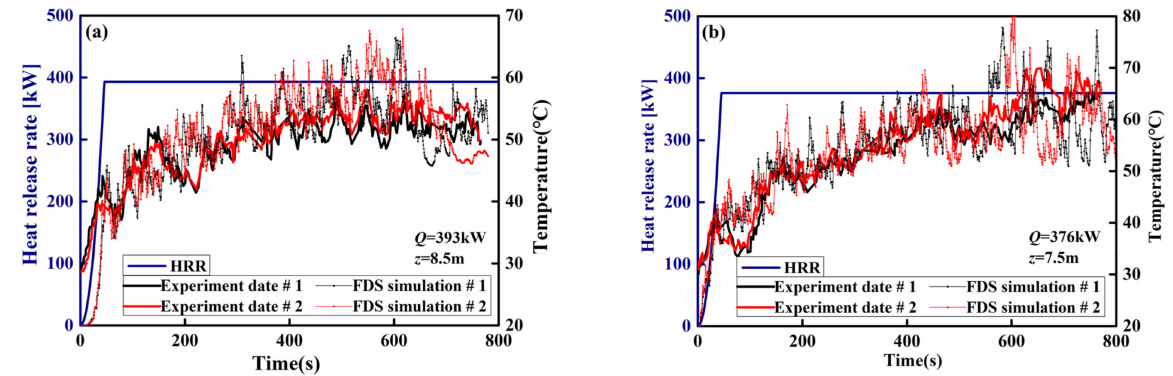
Figure 4. Comparison between the experiments and FDS simulations: ( a ) Q = 393 kW and z = 8.5 m; ( b ) Q = 376 kW and z = 7.5 m.